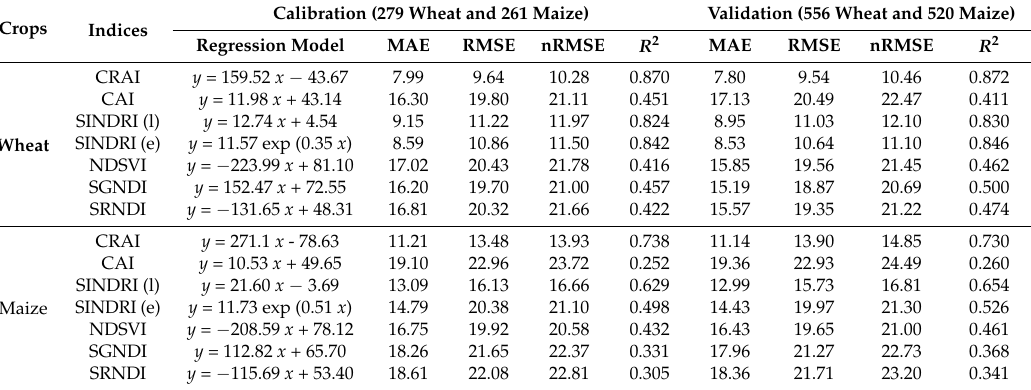
Table A4. Descriptive statistics of regression accuracy [MAE (%), RMSE (%), nRMSE (%), and R 2 ].